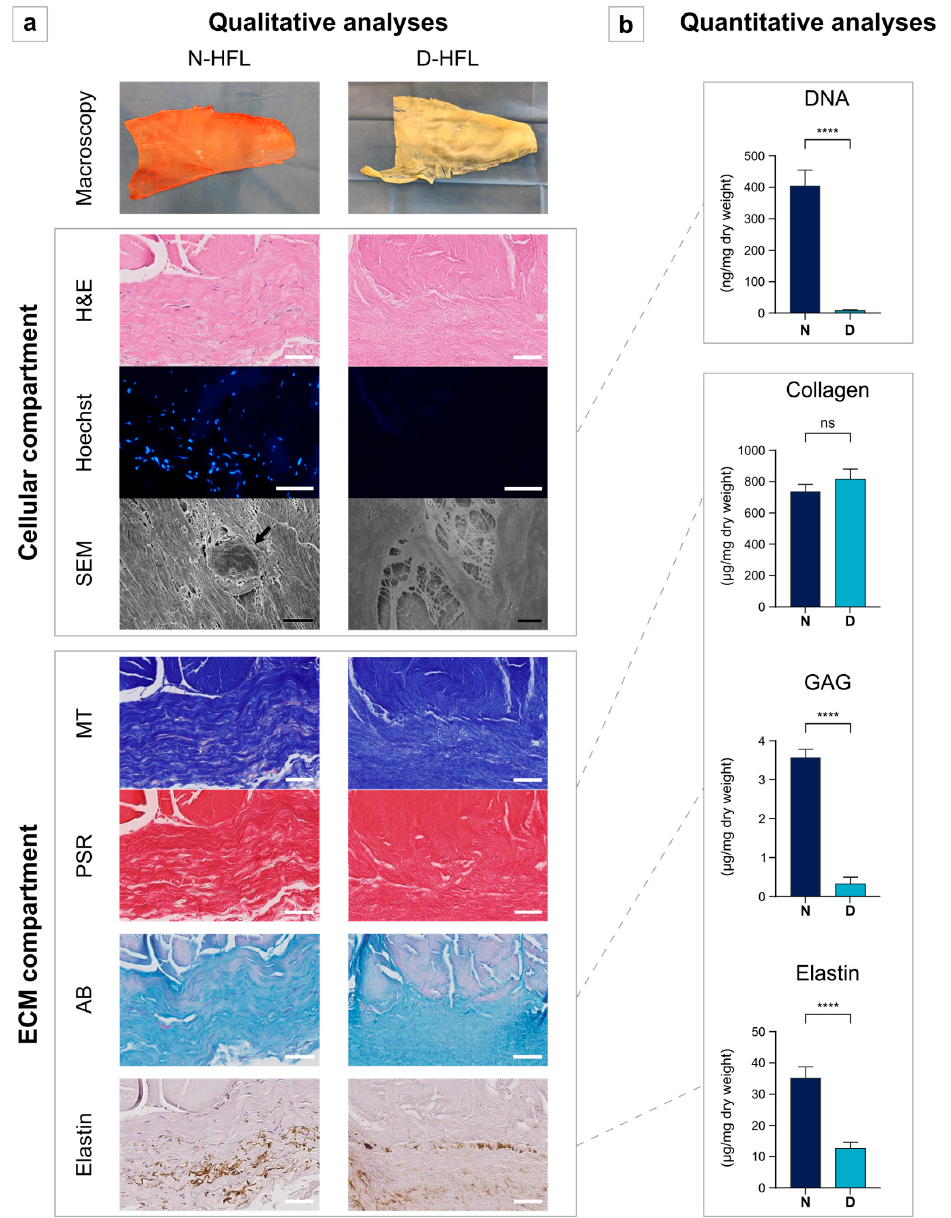
Figure 1. Qualitative ( a ) and quantitative ( b ) evaluation of the cellular and extracellular matrix compartments before/after decellularization. The DNA extraction was achieved with the DNeasy ® Blood & Tissue kit (Qiagen, Italy) and measured using the Quant-iT PicoGreen DNA assay kit (ThermoFisher Scientific). The quantification of the collagen content was carried out using the Quickzyme Total Collagen Assay (Quickzyme, Leiden, Netherlands), the GAG content extraction and dosage by means of the Blyscan Sulfated-GAG assay kit (Bio-color LTD., Carrickfergus, Northern Ireland), and the elastin quantification with the Fast Elastin assay kit (Biocolor LTD., Carrickfergus, Northern Ireland). ECM: extracellular matrix, N-HFL: native human fascia lata, D-HFL: decellularized fascia lata, H&E: hematoxylin and eosin, SEM: scanning electron microscopy, MT: Masson’s trichrome showing collagen fibers, PSR: Picrosirius Red showing collagen fibers, AB: Alcian blue showing proteoglycans, DNA: deoxyribonucleic acid, and GAG: glycosaminoglycans. Black arrow shows a cell. White scale bars: 50 µ m. Black scale bars: 5 µ m. ****: p < 0.0001; ns: